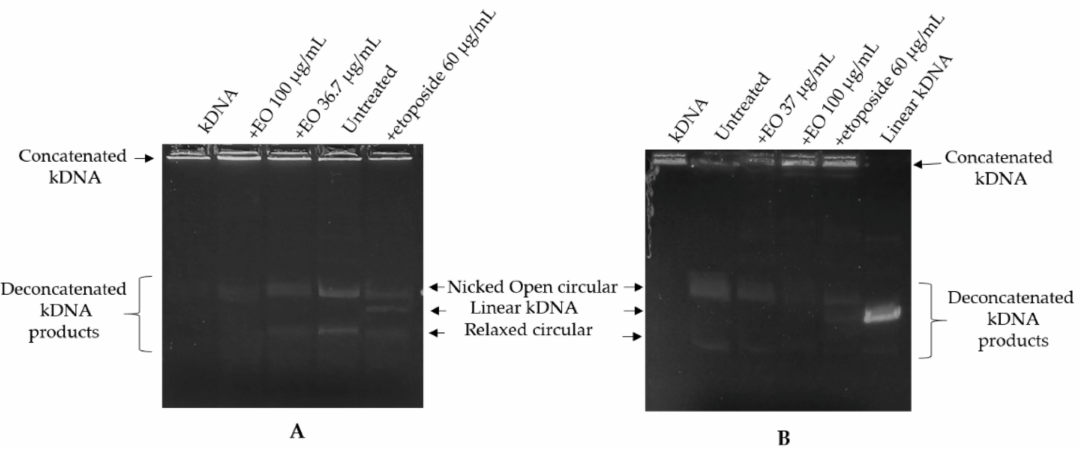
Figure 2. Inhibition of topoisomerase II activity in HL-60 ( A ) and HL-60R ( B ) cell nuclear extracts by G. rosmarinifolia essential oil. Nuclear extracts (200 ng) were treated or not with essential oil, or with etoposide and incubated with kDNA. The panels show a representative experiment of three independent experiments. The decatenated products shown contain open circular (upper band) and covalently closed circular (relaxed) minicircle DNA. Linear kDNA migrates between the affected and relaxed